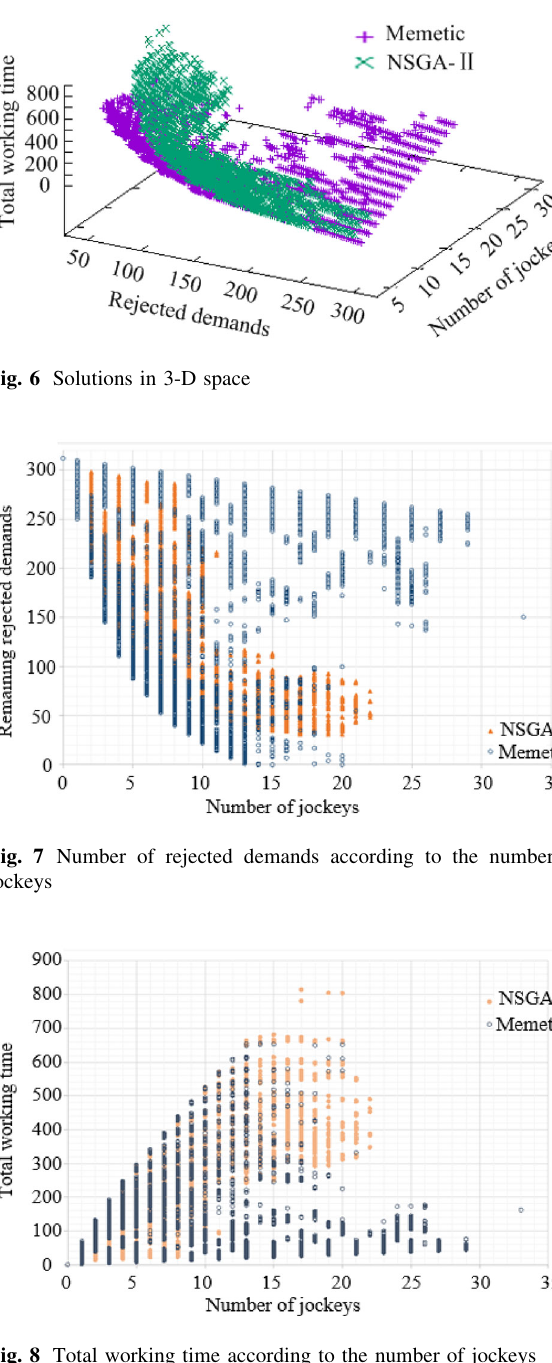
Fig. 8 Total working time according to the number of jockeys